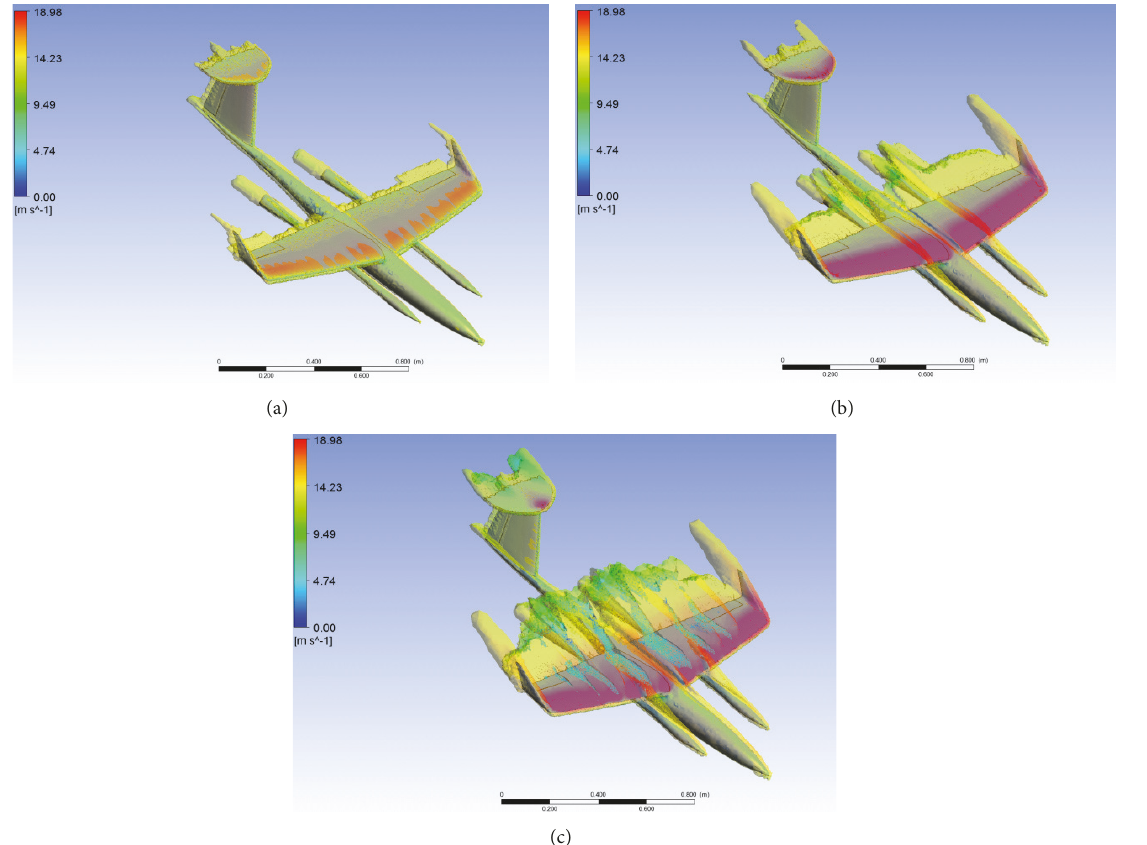
Figure 13: Isosurface of vorticity (Re = 237 000) for 100 s −1 (the color of isosurface represents wind velocity) for: (a) 0 ∘ AoA, (b) 12 ∘ AoA, and (c) 16 ∘